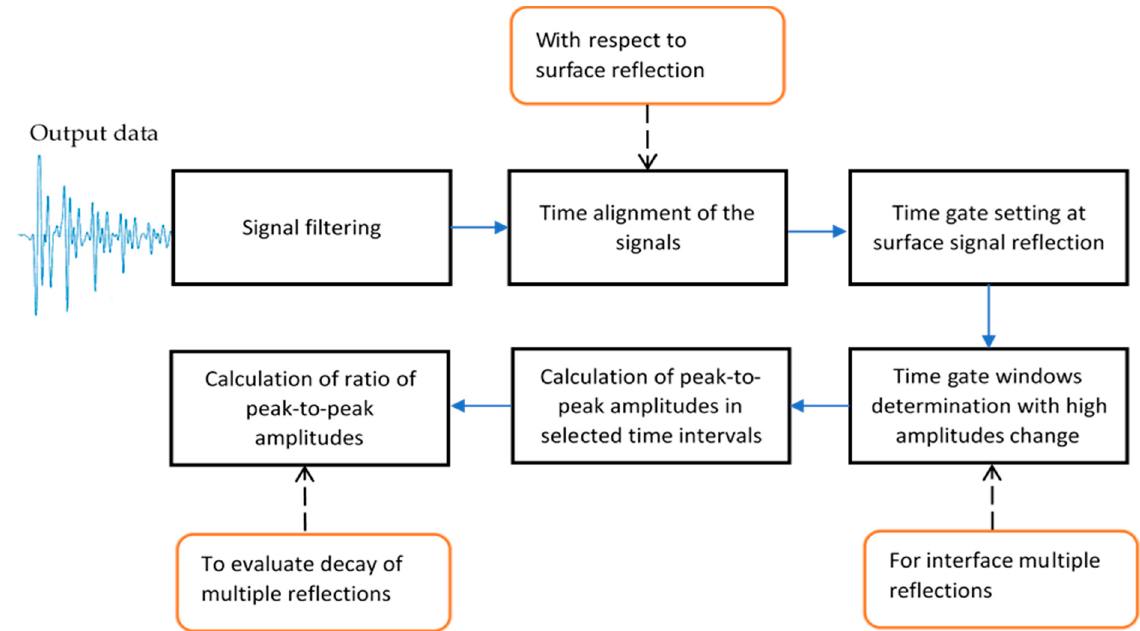
Figure 8. Functional block diagram of main steps of the developed algorithm.